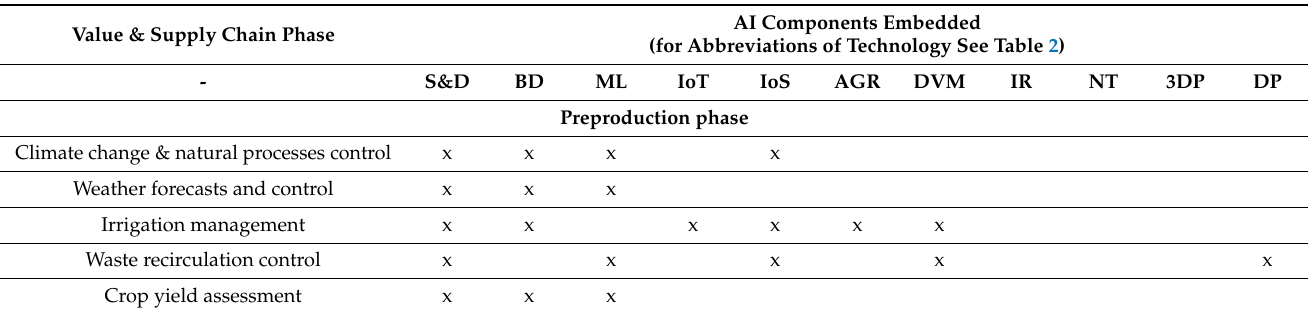
Table 3. Food value and supply chain phases linkage to AI components (own on basis of [29,39–42]). AI Components Embedded (for Abbreviations of Technology See Table